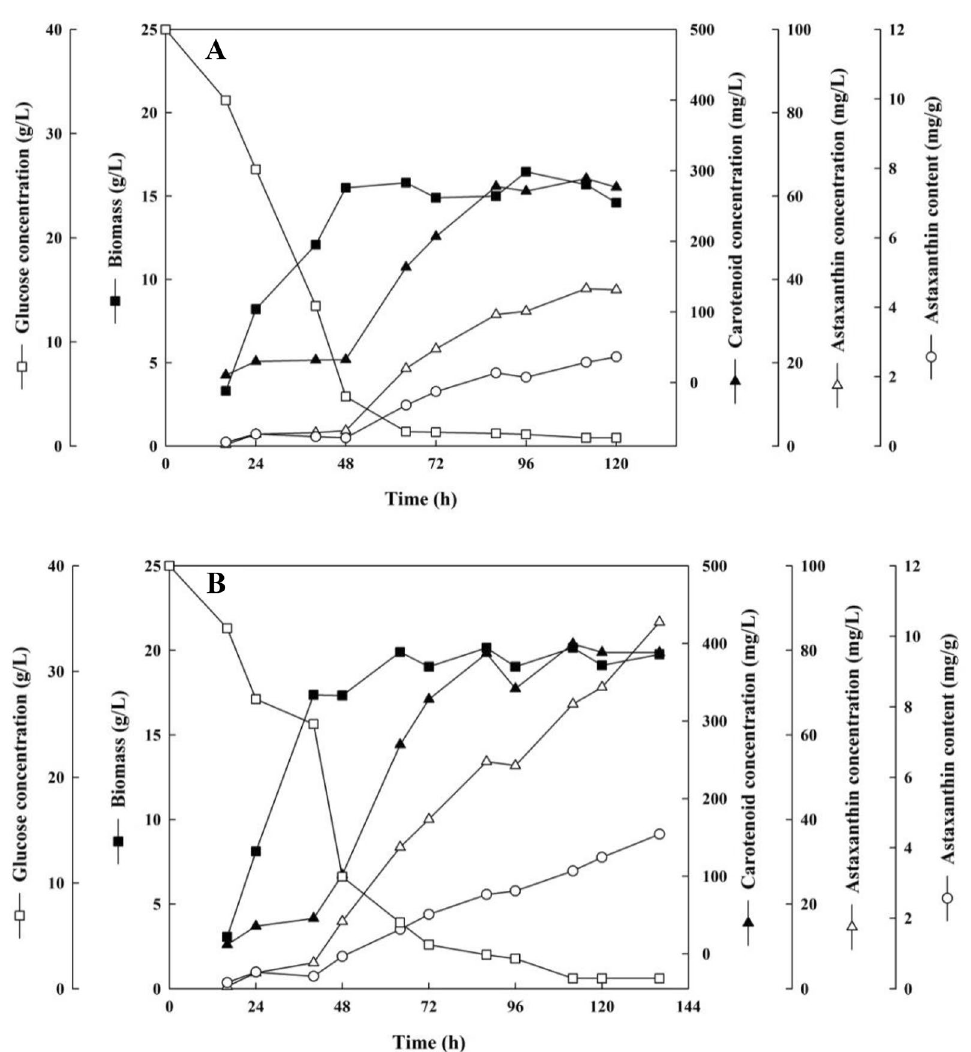
Fig. 2 Profiles of cell growth, glucose consumption, and astaxanthin production of X. dendrorhous in the 5-L bioreactor. A Control group; B Na-citrate group. During the fermentation process, the temperature was maintained at 22 °C, the ventilation rate was 2 vvm, and the stirring speed was amplified step by step (0–24 h, 200 rpm; 24–48 h, 300 rpm; 48–72 h, 400 rpm; 72–120 h, 500 rpm), and the dissolved oxygen (DO) was maintained at more than 30% by the DO cascade. Glucose (open square), biomass (filled square), carotenoid titer (filled triangle), astaxanthin titer (open triangle), and astaxanthin content (open circle). The data shown are the average of two replicates (